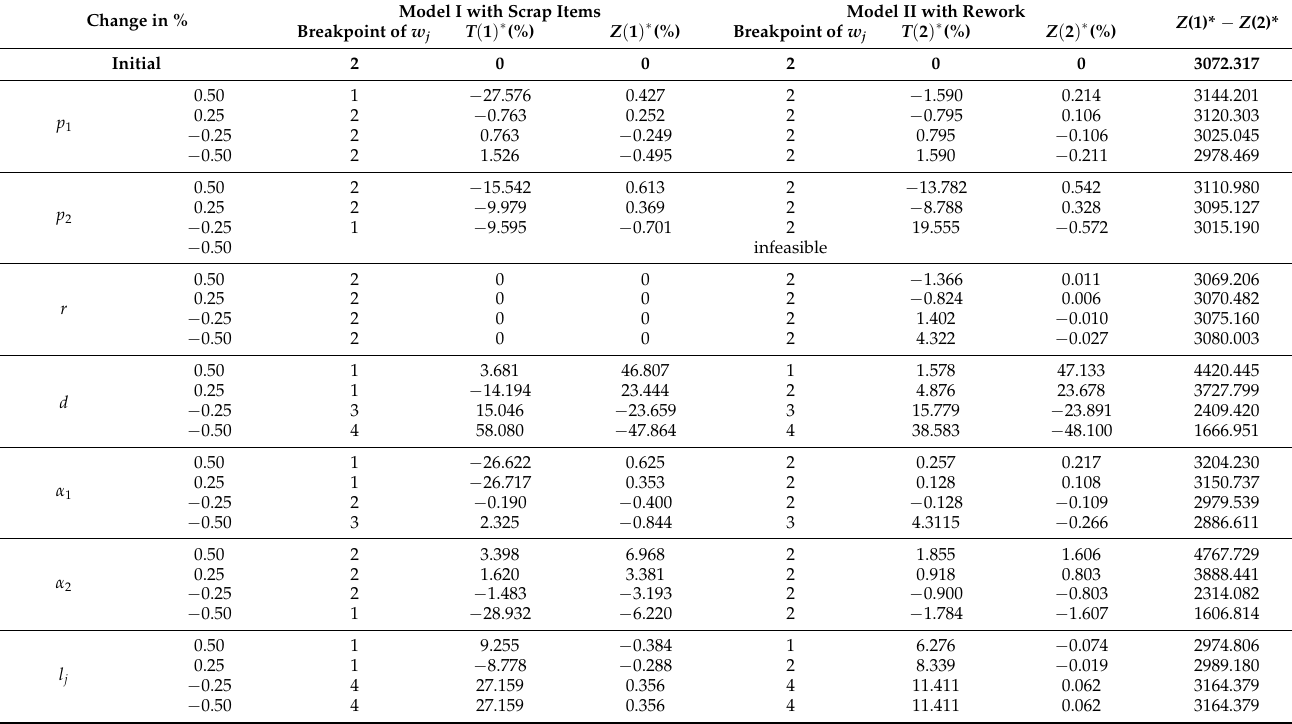
Table 8. The sensitivity analysis of the system